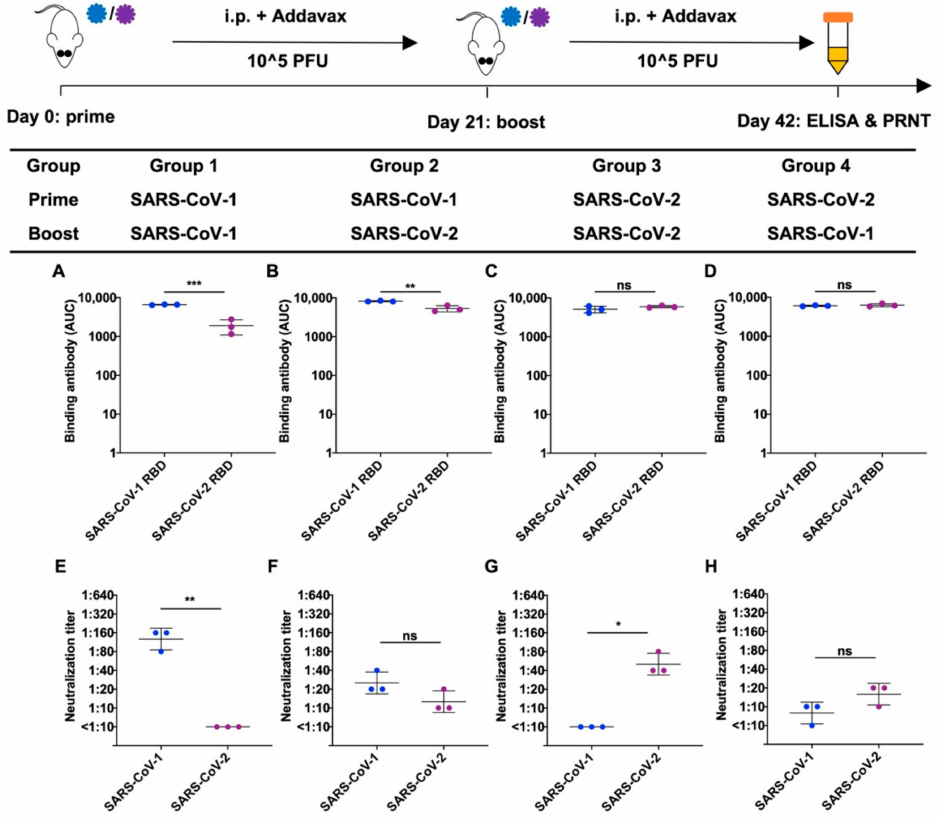
Figure 2. Binding and neutralization of antibodies in mouse plasma 21 days after the homologous or heterologous immunization of SARS-CoV-1 and SARS-CoV-2. Plasma samples were collected on day 21 after two rounds of immunization. ( A – D ) RBD (receptor binding domain) proteins from SARS-CoV-1 and SARS-CoV-2 were used as the antigen coating on the ELISA plates. Binding of RBD to serial diluted plasma sample was analyzed from three mice immunized using ( A ) SARS-CoV-1 homologous prime-boost, ( B ) heterologous SARS-CoV-1-prime, SARS-CoV-2-boost, ( C ) SARS-CoV-2 homologous prime-boost, and ( D ) heterologous SARS-CoV-2-prime, SARS-CoV-1-boost. AUC, area under the curve. ( E – H ) Neutralizing titers (PRNT 90 ) of plasma samples from mice immunized with ( E ) SARS-CoV-1 homologous prime-boost, ( F ) heterologous SARS-CoV-1-prime, SARS-CoV-2-boost, ( G ) SARS-CoV-2 homologous prime-boost, and ( H ) heterologous SARS-CoV-2-prime, SARS-CoV-1- boost, were analyzed by a PRNT (plaque reduction neutralization test) assay. Each data point in the figure represents the mean of two replicates. Error bars represent standard deviation. p -values were calculated using a two-tailed t -test (* p < 0.05, ** p < 0.01, *** p < 0.001, ns (not